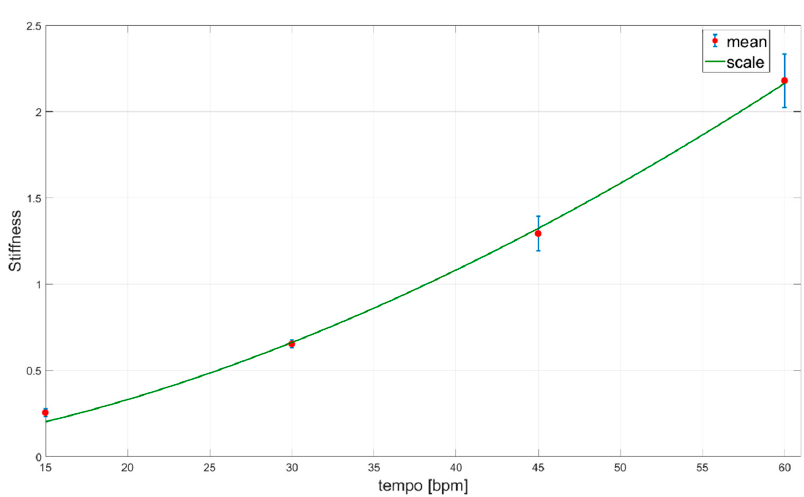
Figure 7. Stiffness fitting curve (green curve) for different task tempos (E1). Mean value for all participants is represented by red dots and the corresponding standard deviation is represented by blue lines.